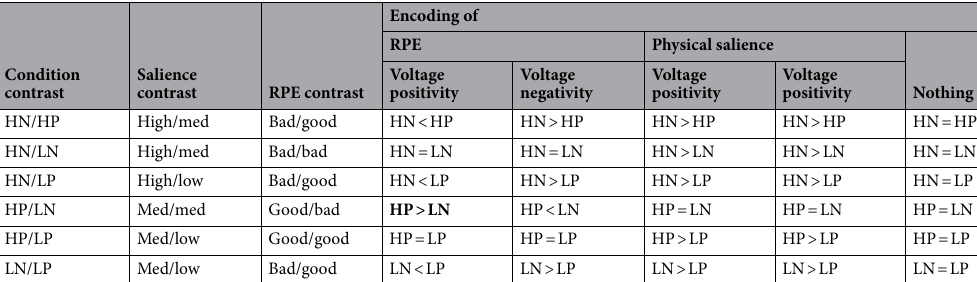
Table 1. Rows designate the six pairwise contrasts available from the design. Columns 4–8 show the predicted effects that five different encoders will show in each contrast. The quantity compared in these contrasts is positivity of voltage. The emboldened cell identifies the single critical contrast used for the first analysis strategy.